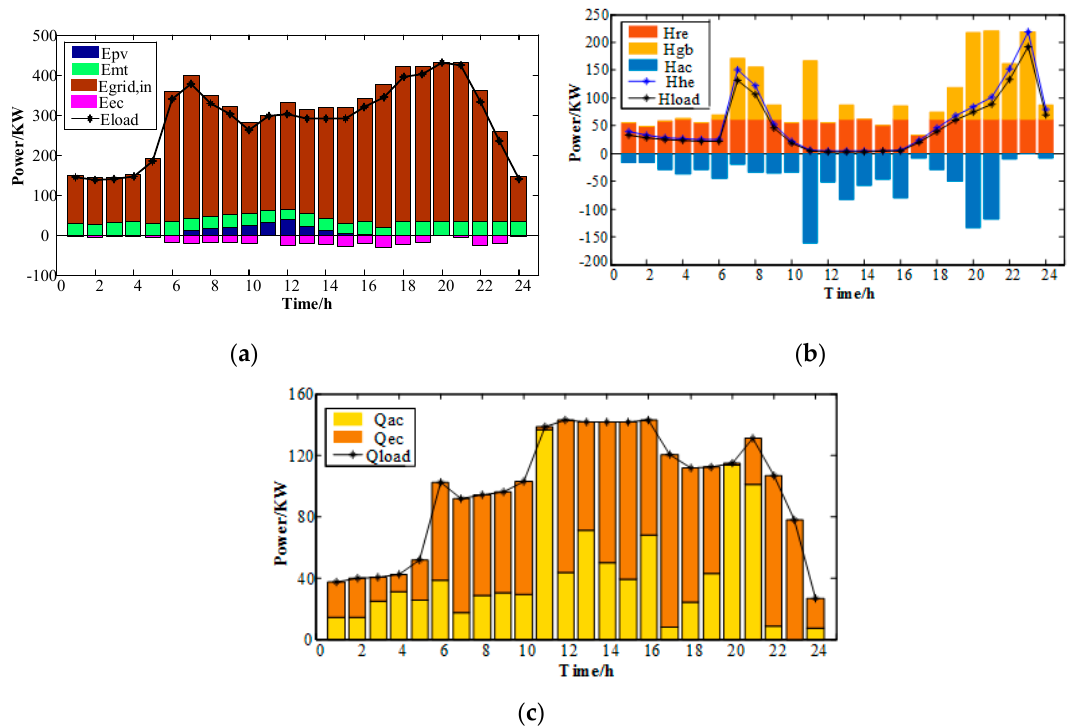
Figure 7. Power balance diagram under the FHL strategy: ( a ) Electric load balance; ( b ) Heat load balance; ( c ) Cold load balance.